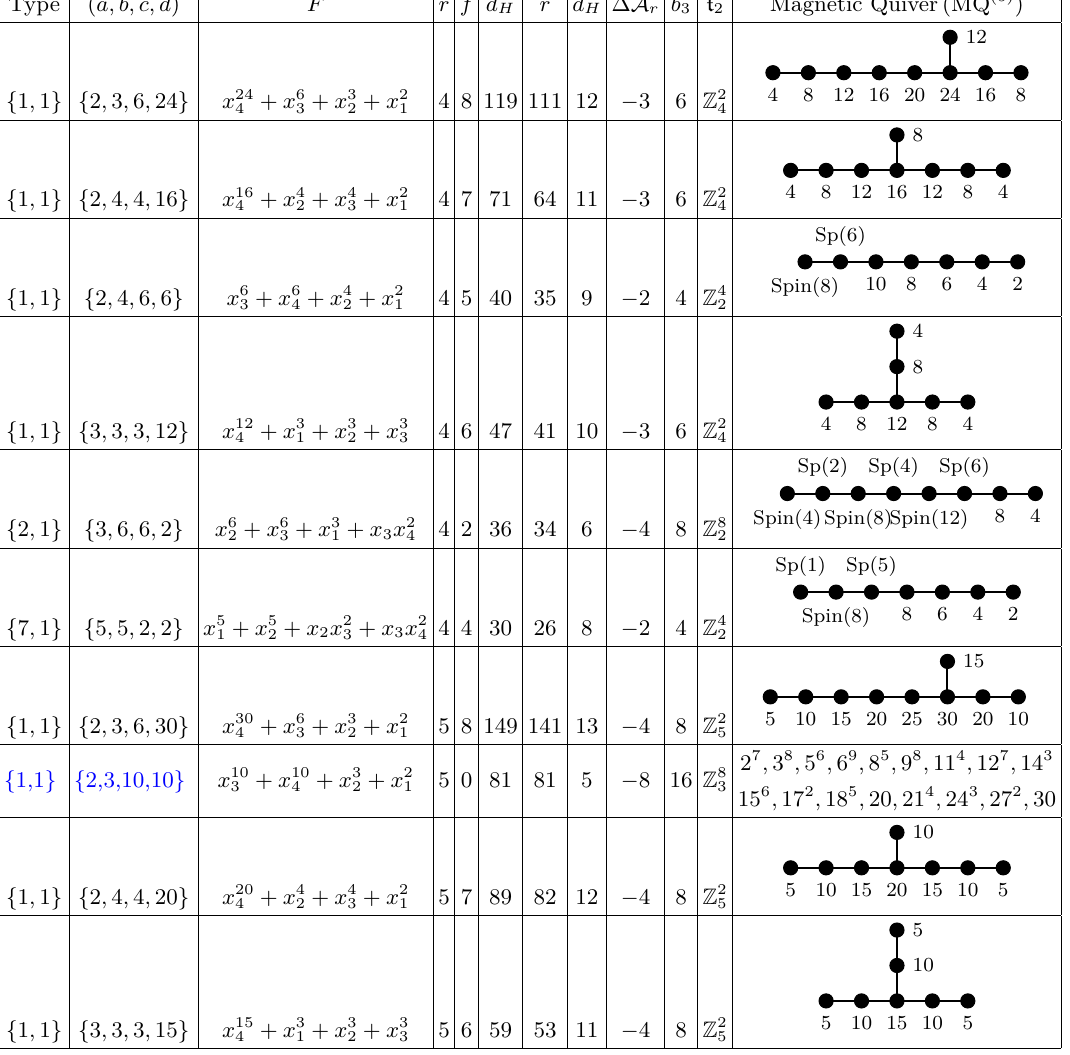
Table 11 . Rank r = 4 , 5 Models with smooth divisors and b 3 > 0 . Blue indicates models that have a D b ( G ) trinion p